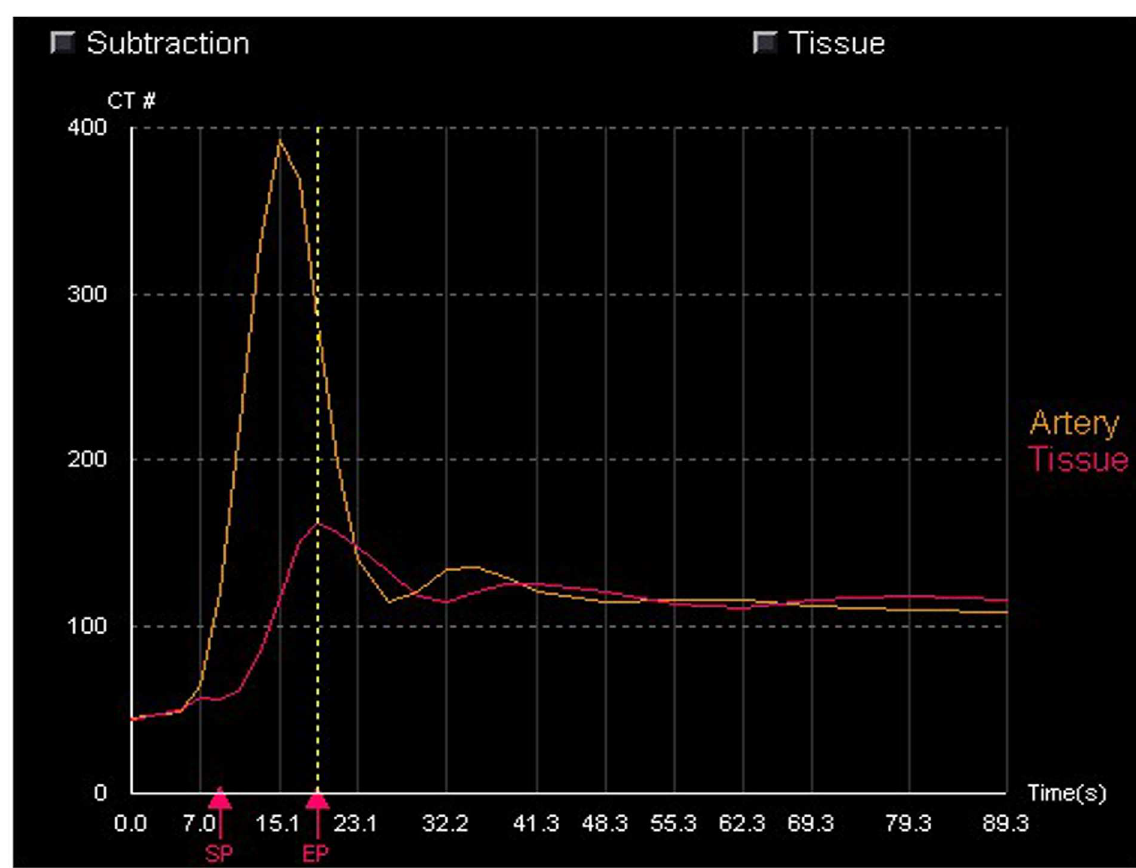
Fig 5. Time—density curves (TDCs) from the single input maximum slope. TDC indicatesthe enhancement characteristics of the aorta and renal cortex duringthe first pass. BF can be determined from the maximum gradientof renal cortex.